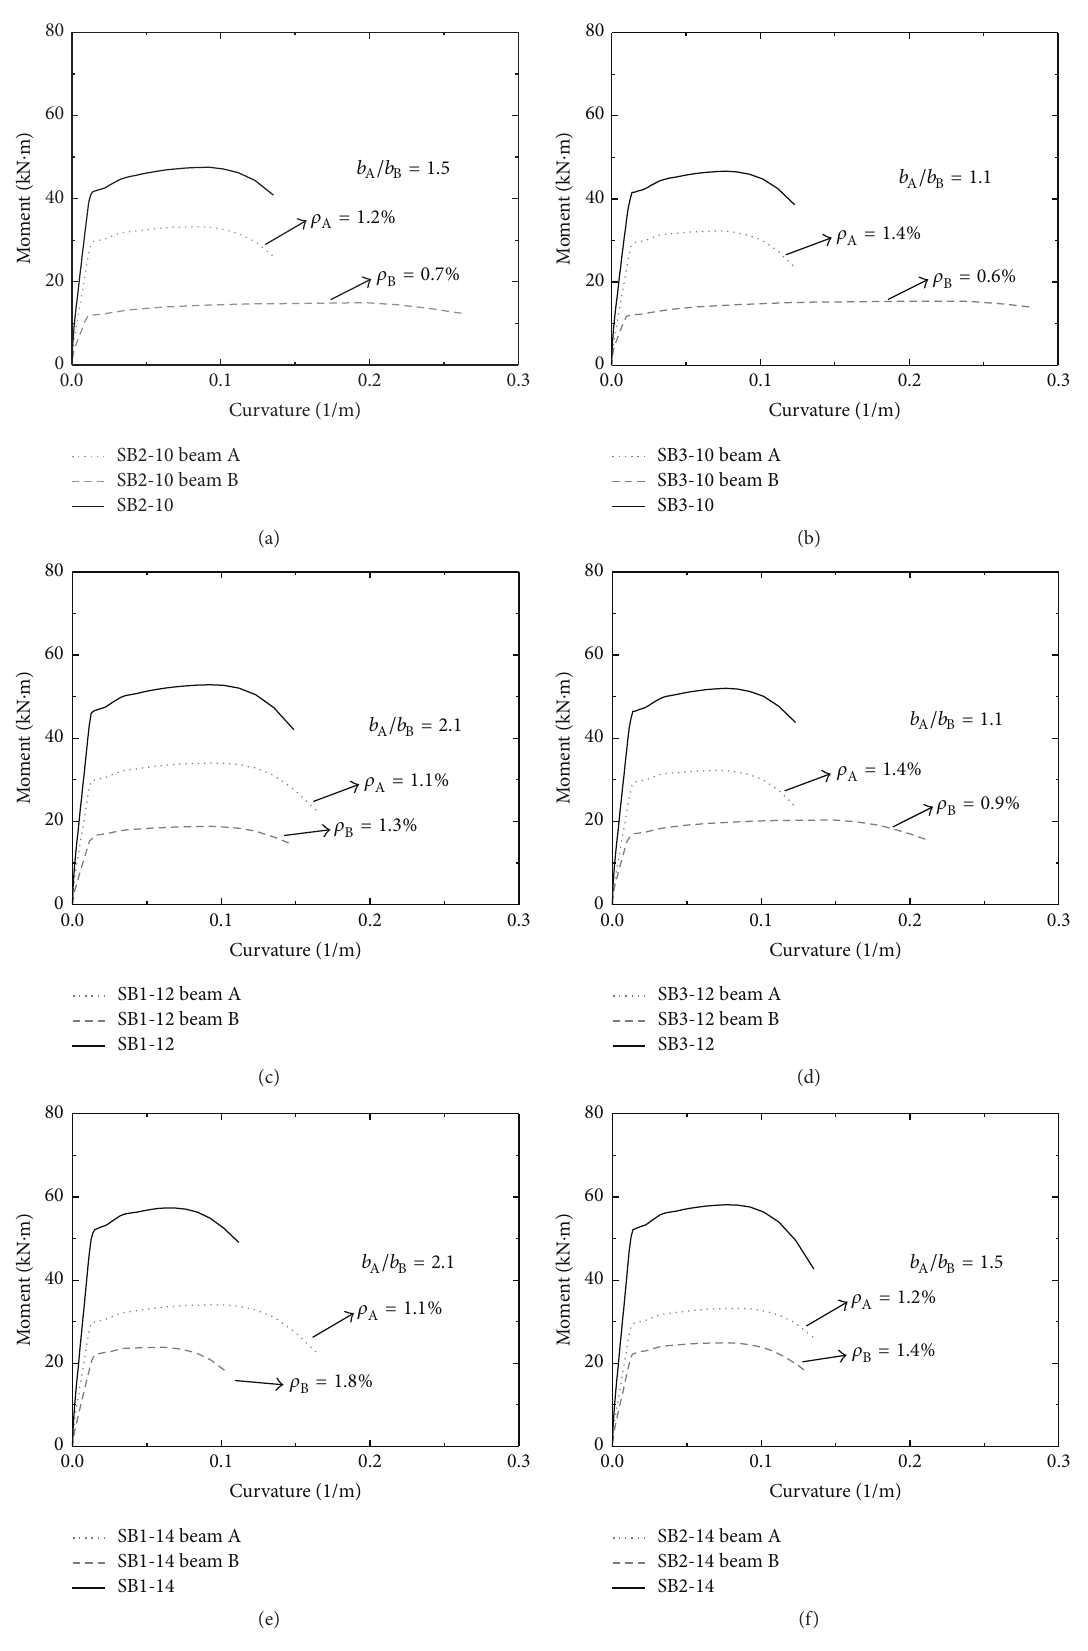
Figure 8: Moment curvature curves of the slotted beams: (a) SB2-10; (b) SB3-10; (c) SB1-12; (d) SB3-12; (e) SB1-14; and (f)